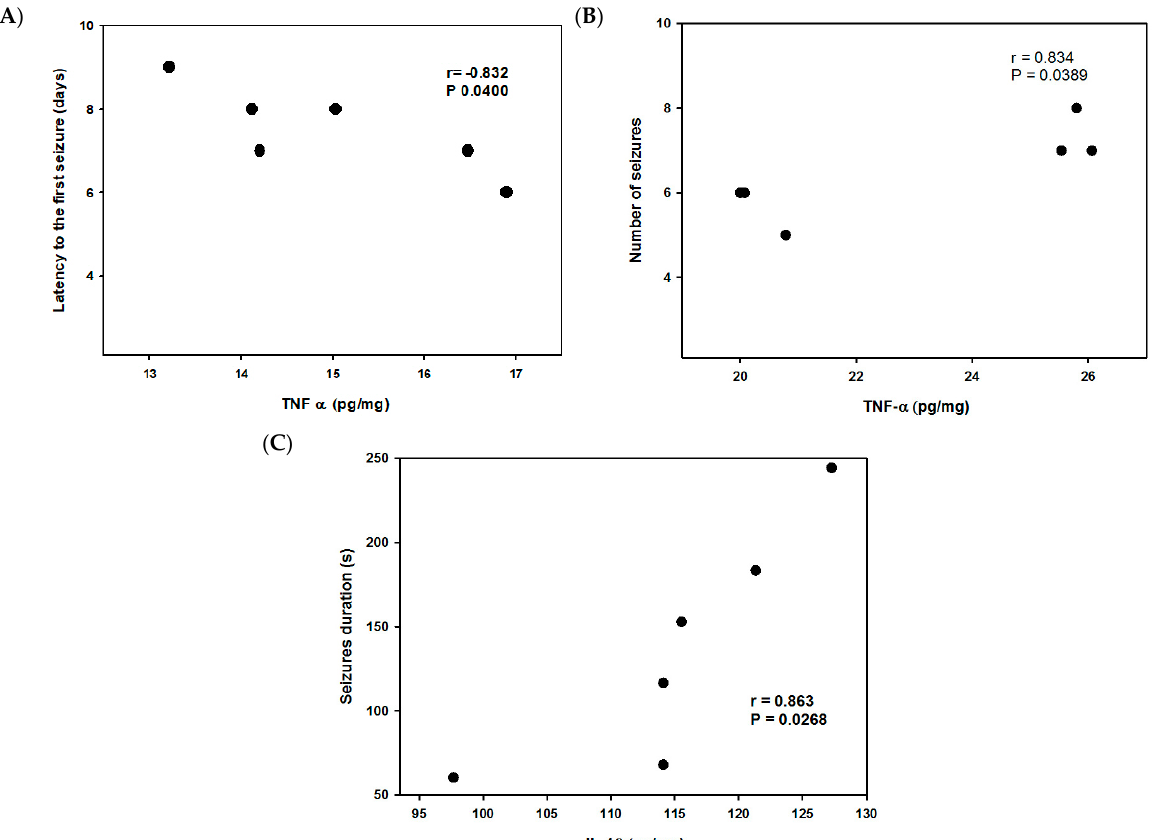
Figure 3. ( A ) Correlation between TNF- α concentration and the latency to the first seizure in the TAL50 group at day 8 post-SE. ( B ) Correlation between TNF- α concentration and the number of SRS in the TOP group at 28 days post-SE. ( C ) Correlation between IL-1 β concentration and the duration of SRS in the TAL25 group at 18 days post-SE. p < 0.05 Pearson correlation. (n = 6).